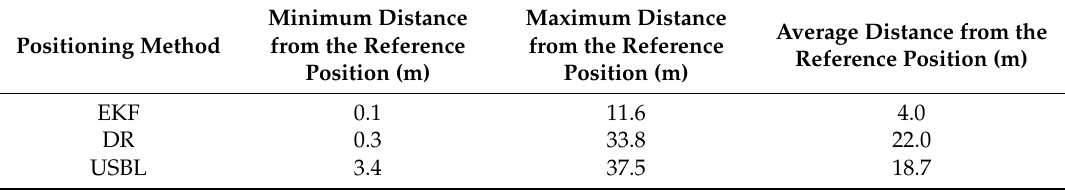
Table 9. Statistical parameters of positioning errors using EKF, DR methods and the USBL system (single passage).